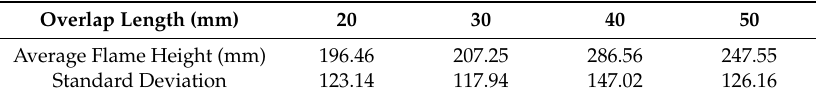
Table 5. Average value and standard deviation of flame height of vertical PMMA plate array with di ff erent overlap